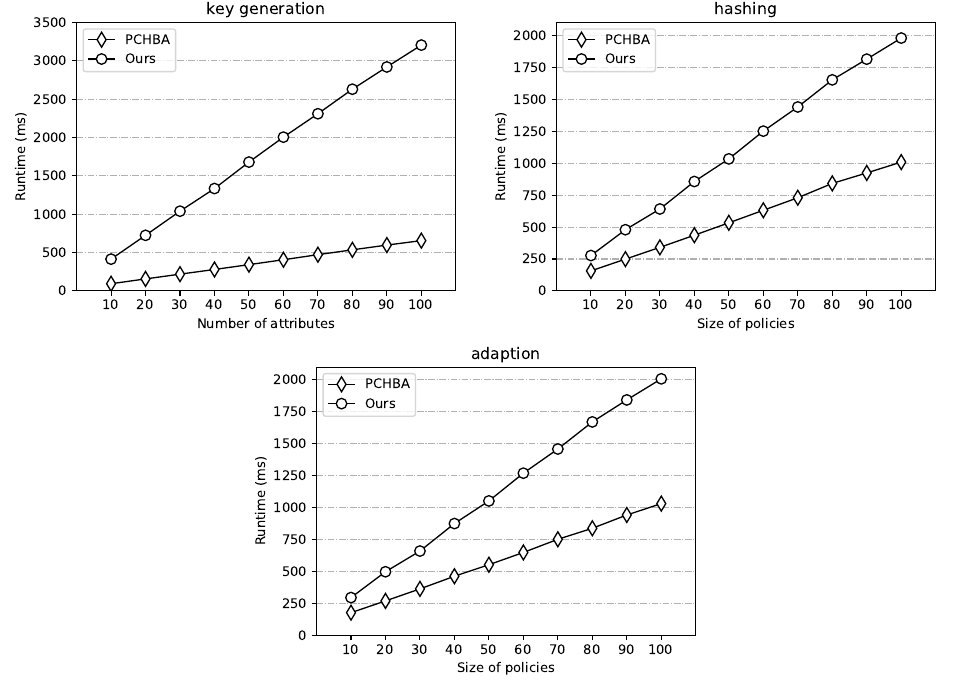
Figure 3. Experimental